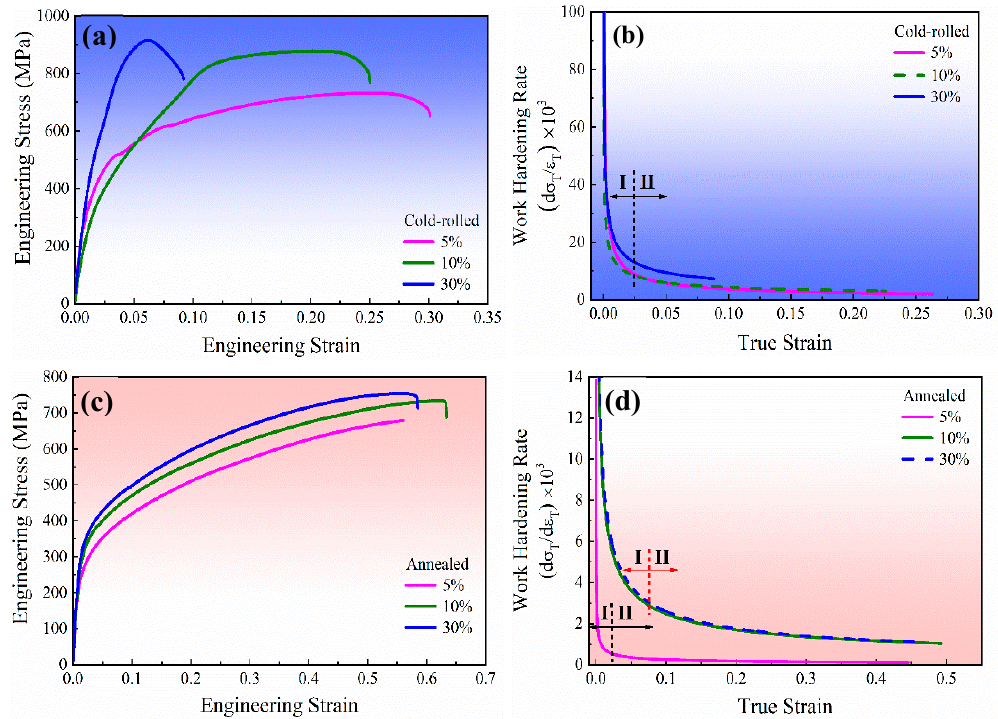
Figure 11. Engineering stress-strain curves ( a and c ), and the corresponding work hardening rate curves ( b and d ) with true strain of the AFA steel after cold-rolled deformation and annealing. σ T and ε T represent true stress and true strain, respectively. Table 4. Tensile properties of the AFA steel subjected to cold-rolled deformation and annealing treatment, respectively.